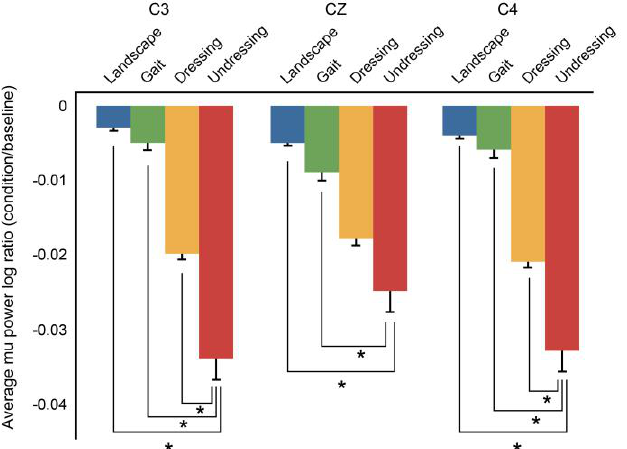
Figure 4. C3, CZ, C4 of average mu power log ratio. Mu inhibition concerning landscape, gait, dressing and undressing conditions of each hemisphere C3, CZ and C4 is indicated. The error bars for each condition represent the standard error of the mean. Significant inhibition is shown by (* p < 0.05).